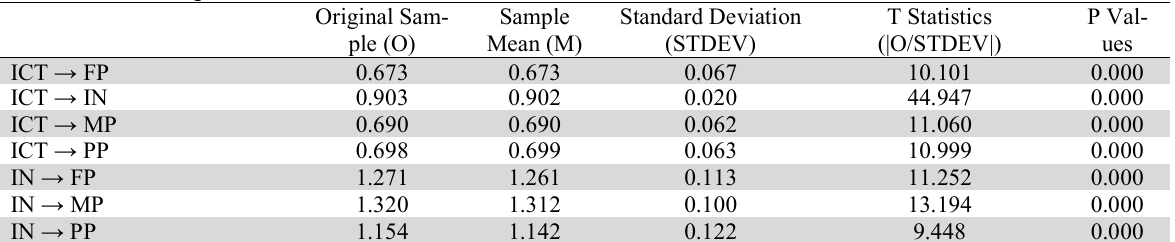
Direct relationships